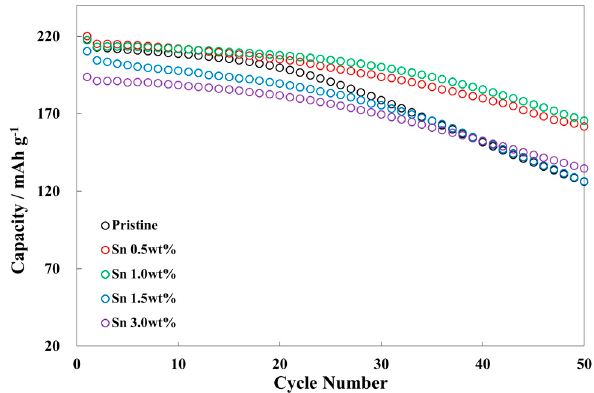
Figure S1: SEM cross-section images of the cathode active materials; Figure S2: EDS cross-section mapping of the cathode active materials: ( a ) pristine, ( b ) Sn 0.5 wt %, ( c ) Sn 1.0 wt %, and ( d ) Sn 1.5 wt %; Figure S3: Wide XPS of the cathode active materials.